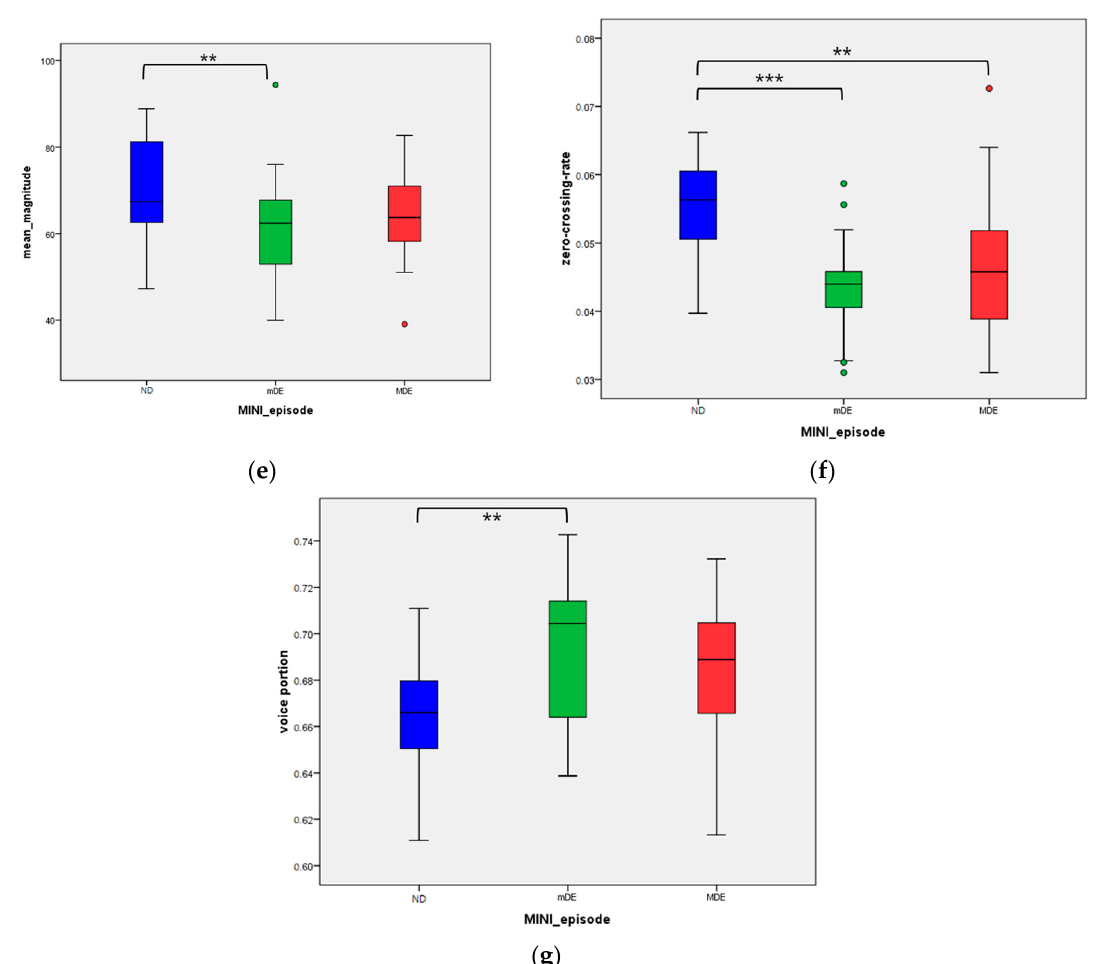
Figure 1. Difference of voice features by depressive episode by Benjamini–Hochberg test: ( a ) Spectral_centroid between three groups; ( b ) spectral_rolloff between three groups; ( c ) sq_mean_pitch between three groups; ( d ) stdev_pitch between three groups; ( e ) mean_magnitude between three groups; ( f ) zero-crossing-rate between three groups; ( g ) voice portion between three groups. * p value < 0.05, ** p value < 0.01, *** p value < 0.001. Abbreviations: ND—not depressed, mDE— minor depressive episode, MDE—major depressive episode, sqrt—square root, sq—squared, stdev—standard deviation.